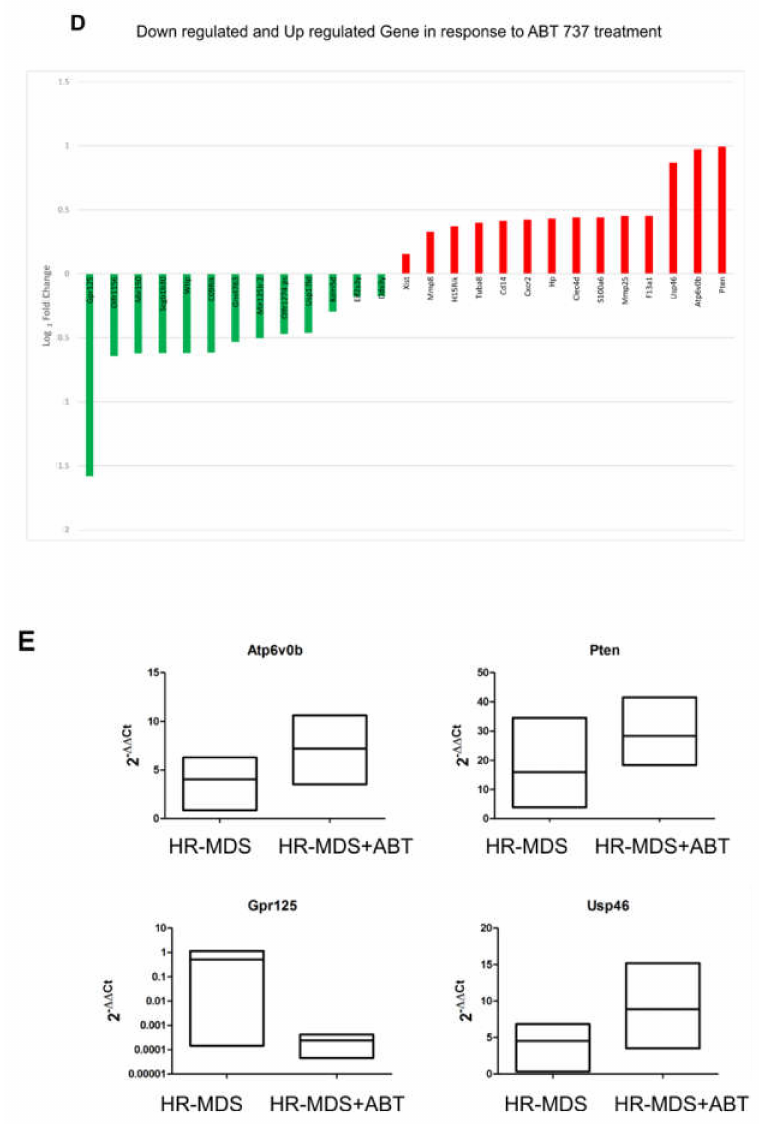
Figure 4. Gene expression profiling reveals differential gene expression signatures after ABT-737 treatment. ( A ) Exon-specific microarray heat map of Sca-1+ enriched spleen cells from untreated HR-MDS mice ( n = 3) compared to treated HR-MDS mice ( n = 3) relative to normal FVB/N. Each row represents an independent mouse in each group; ( B ) Venn diagram showing common and unique differentially expressed genes between ABT-737 treated/control HR-MDS model and human MDS RAEB1 v control samples [13]; ( C ) Diagram of significant KEGG Pathways with p -value; ( D ) Significantly dysregulated genes identified between ABT-737 treated and control HR-MDS cells (Fold-Change > 1.5; p < 0.05); ( E ) RQ-PCR ATP6v0b (upregulated), Pten (upregulated), Gpr125 (downregulated) and Usp46 (upregulated), representative genes regulated in